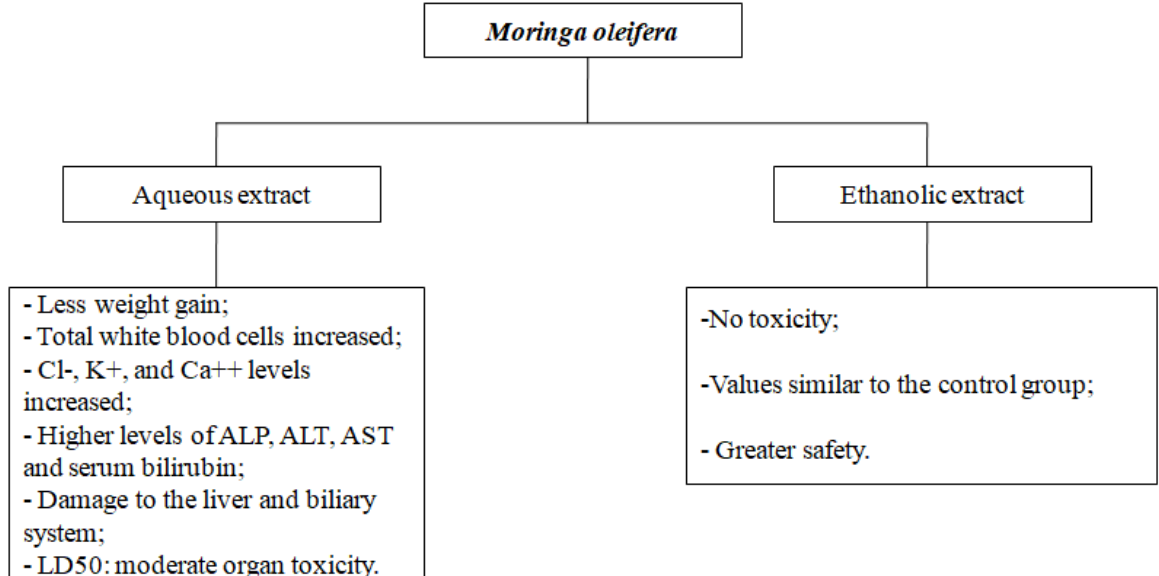
Figure 2. Schematic representation of data referring to the study carried out by Kasolo et al. 2012 on the toxicity of the aqueous and ethanol Moringa oleifera leaves